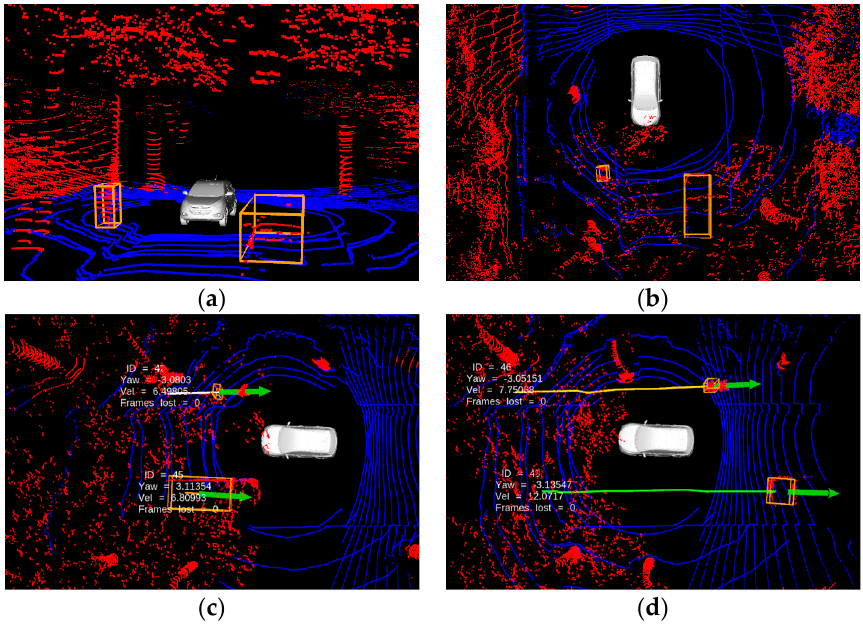
Figure 7. Detection and tracking of vehicles and pedestrians under the cover of tree branches: ( a ) front view; ( b ) top view; ( c ) tracking at initial stage; ( d ) mature tracks.